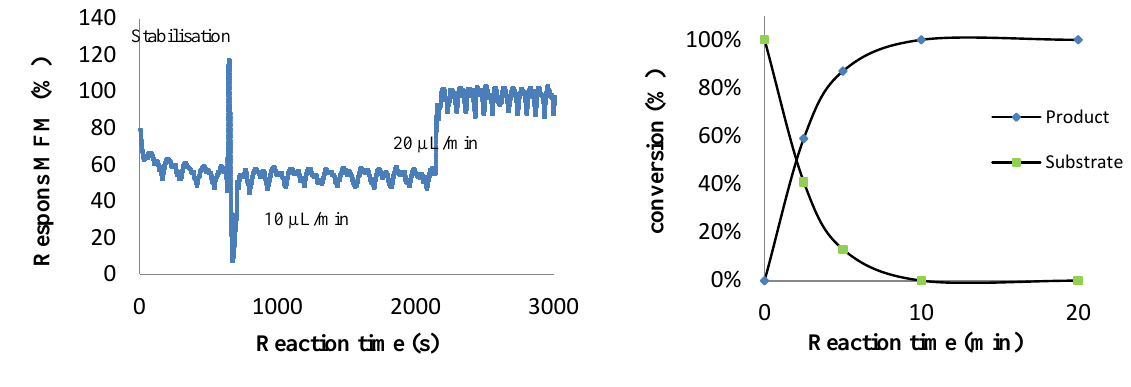
Figure 7. Flow metering of the photochemical reaction.